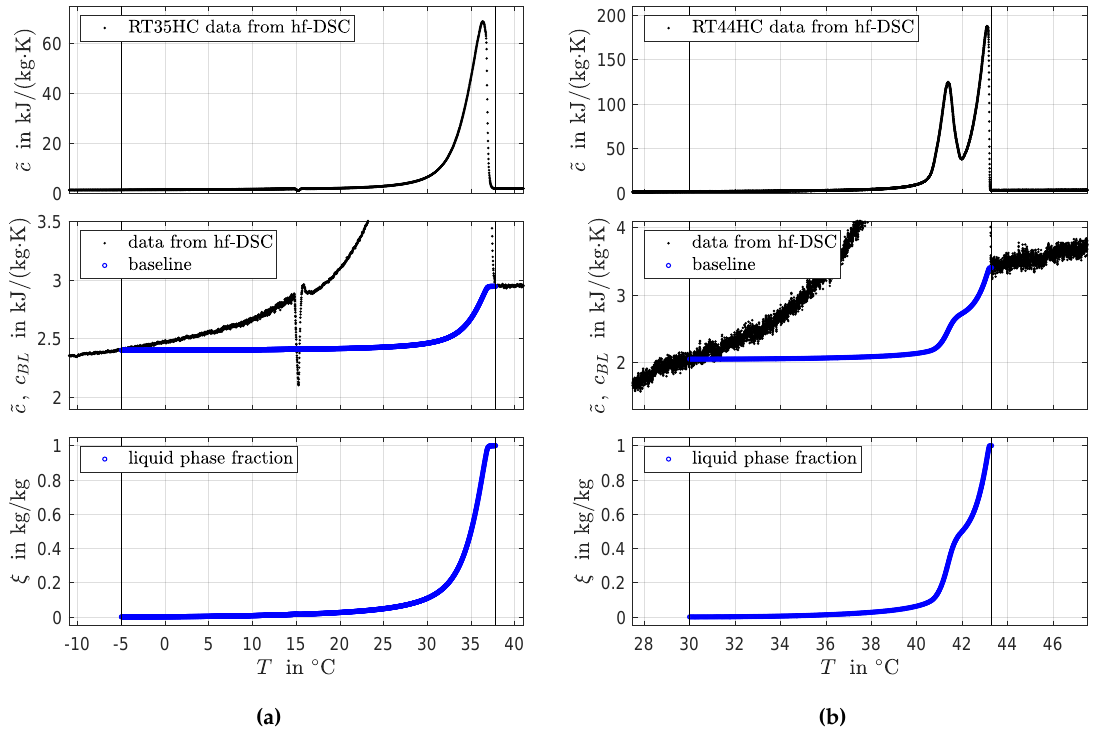
Figure 4. Area-proportional baseline method applied to heat capacity data from hf-DSC. ( a ) RT35HC data recorded at 1 K/min. ( b ) RT44HC data recorded at 0.1 K/min. The slopes of c s p and c l p at the start and end of the phase transition temperature range are neglected. Baseline and phase fractions are constructed as discrete signals by numerical integration. The sudden jump in the DSC signal on the left around 15 ◦ C is caused by a momentary deviation of the temperature controller from the programmed heating